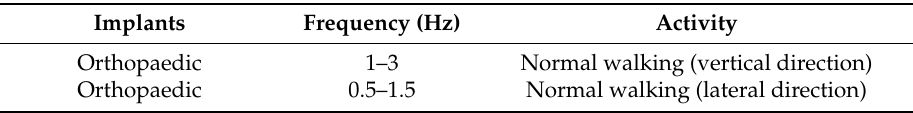
Table 3. Frequency range for orthopaedic applications. Modified from